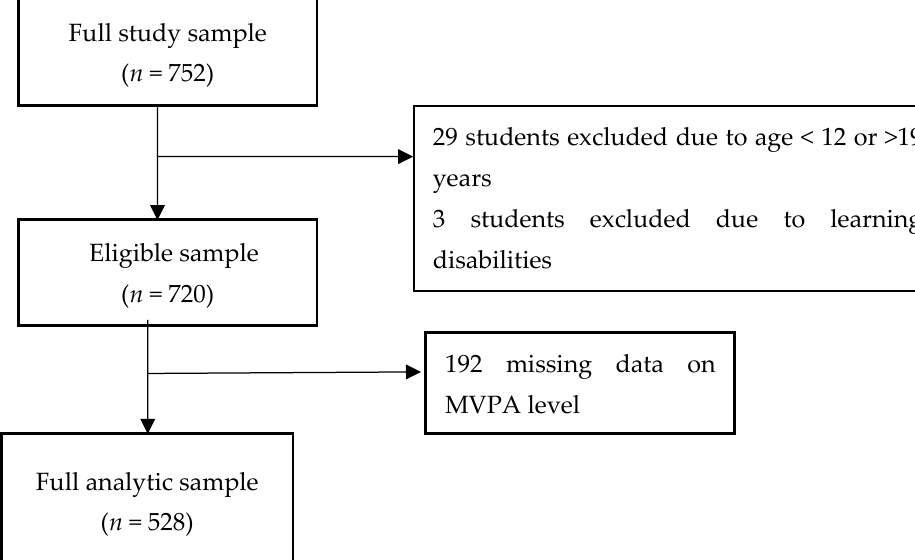
Figure 1. Flowchart of the study participants.